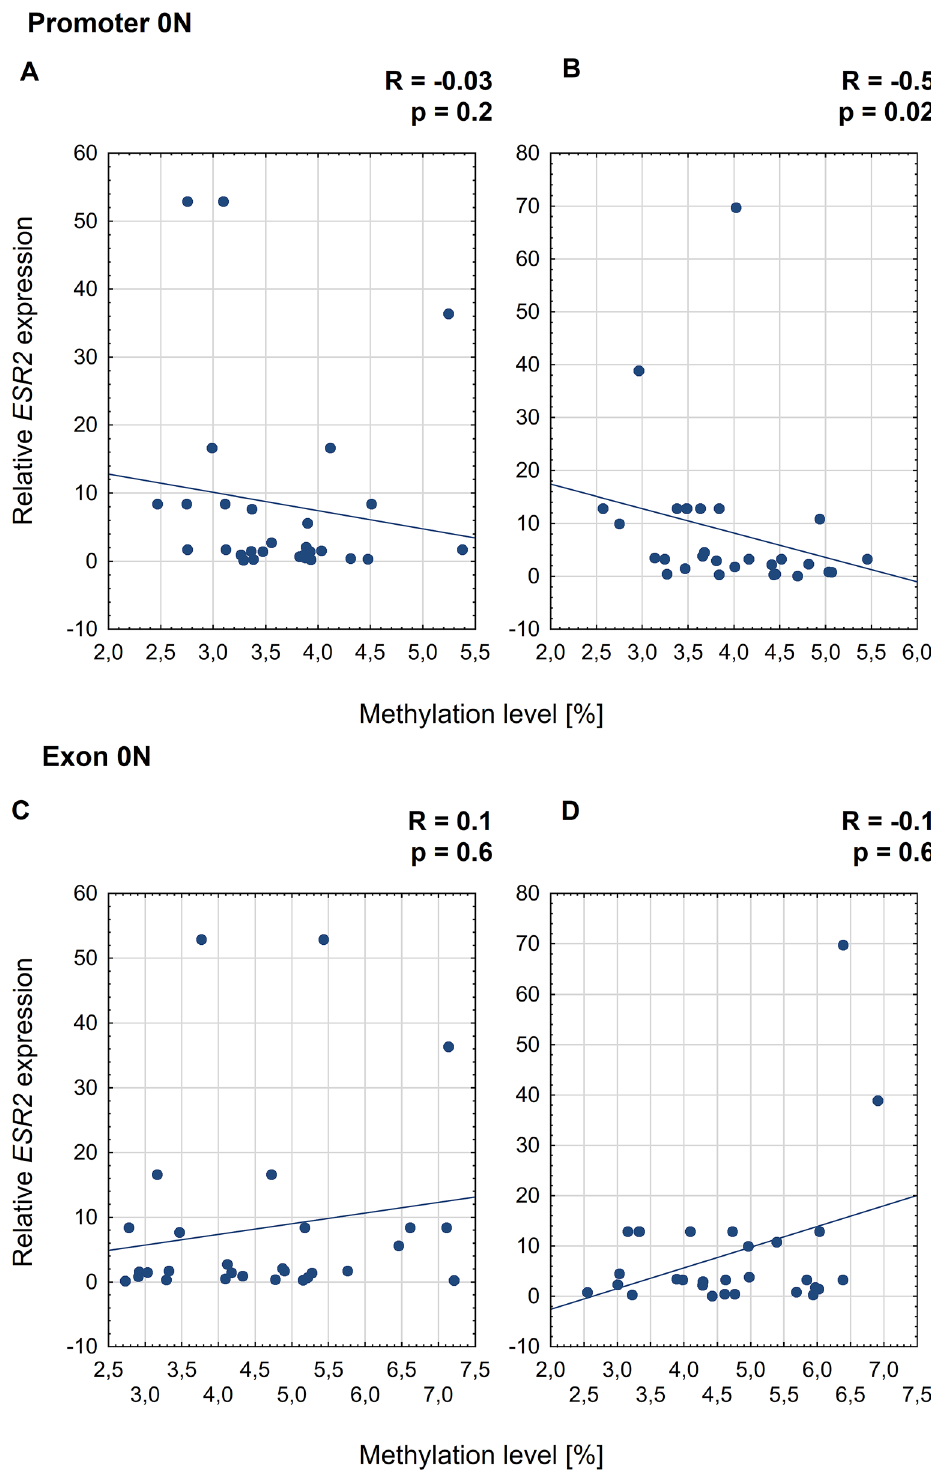
Figure 3. Correlation between ESR2 expression and mean methylation level in promoter 0N and exon 0N on the convex ( A , C ) and concave ( B , D ) side of the